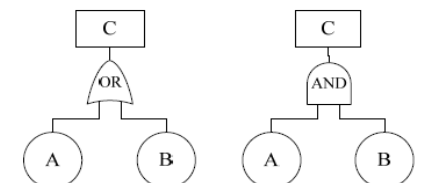
Figure 1. Tree associated with errors A, B, C